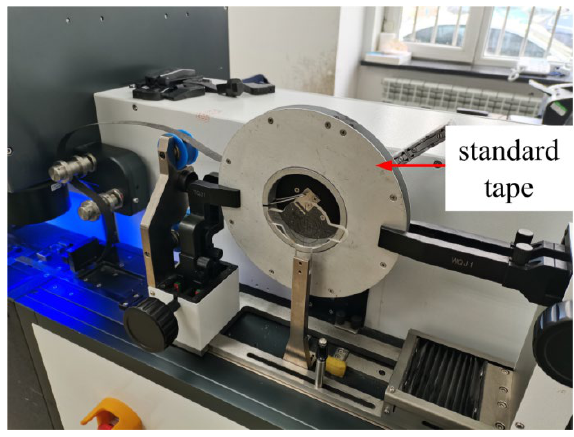
Figure 12. Repeatability test of SMTCD .